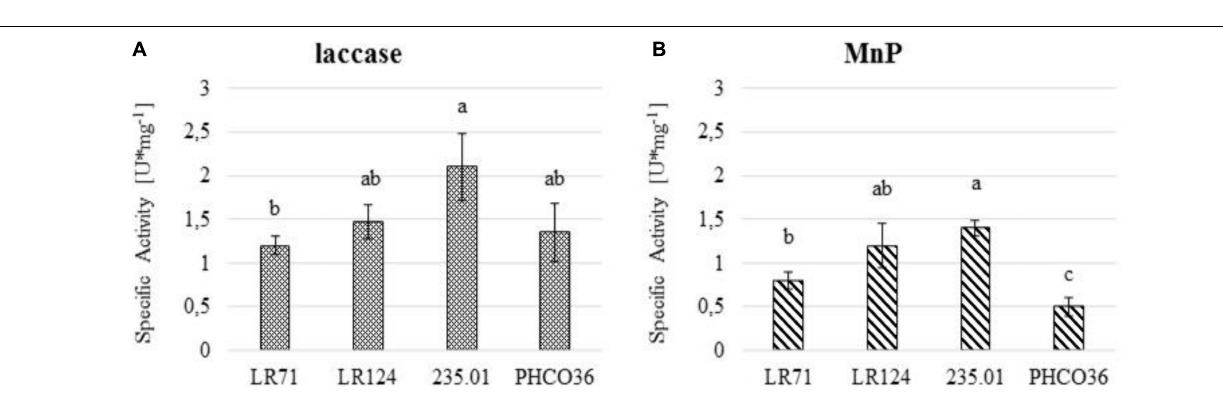
FIGURE 8 | (A) Specific laccase and (B) manganese peroxidase (MnP) activity of 4 strains of Fmed measured by spectroscopy. Fmed liquid culture filtered secretome was used to measure the specific enzyme activity. U/mg unit represents 1 µ mol of substrate oxidized per minute per mg of protein. ANOVA was performed to determine significant differences ( p ≤ 0.05), and Tukey’s test was performed for statistical group identification. Error bars on histograms represent the standard error of the